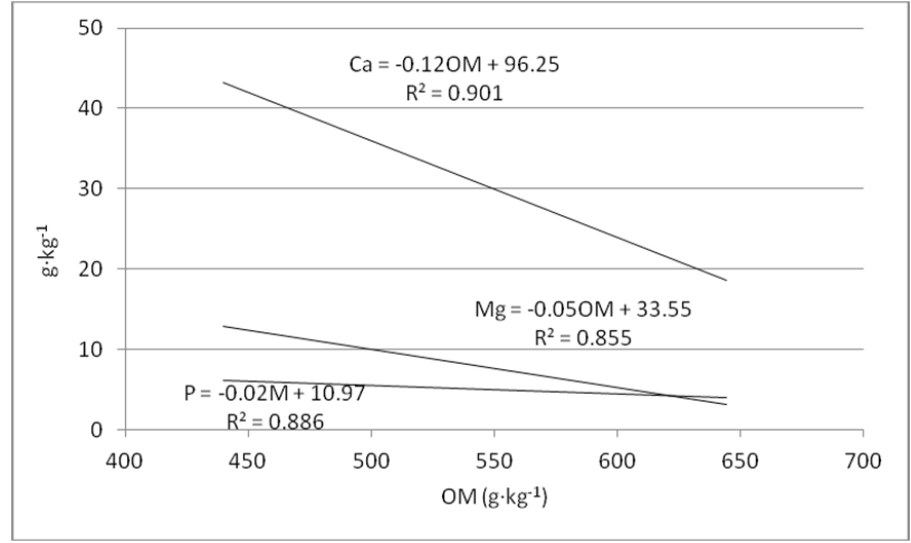
Figure 6. Linear regression for organic matter (OM) and Ca, P and Mg in vermicomposts.